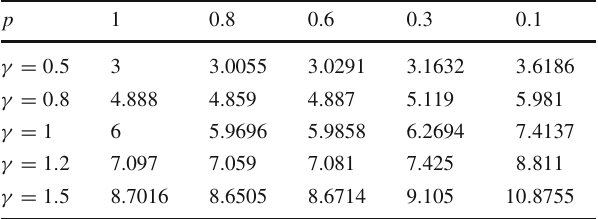
Table 1 The innermost stable circular orbits for test particles moving in the stationary ZV metric